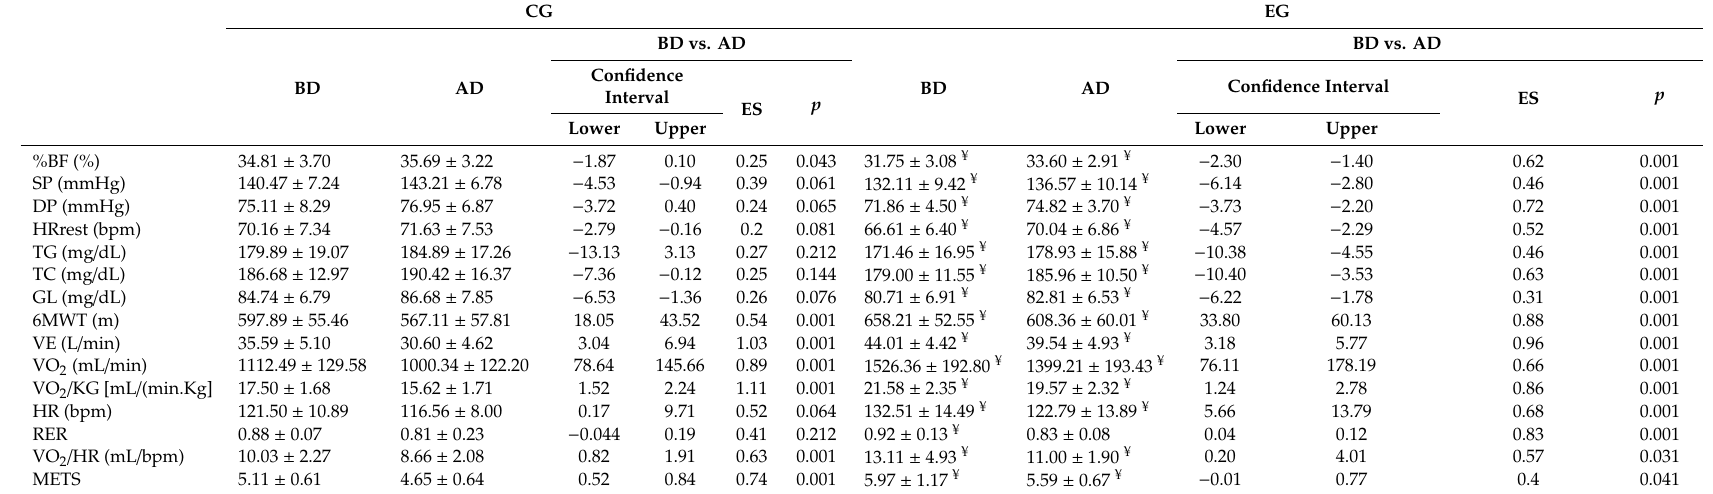
Table 3. Comparison between the variables of the lipidic, glycemic and hemodynamic profiles and cardiorespiratory fitness at the beginning of detraining (BD) and after three months of detraining (AD) in the exercise group (EG) and the control group (CG). CG EG BD vs. AD BD vs. AD Confidence Confidence Interval BD AD BD AD Interval p